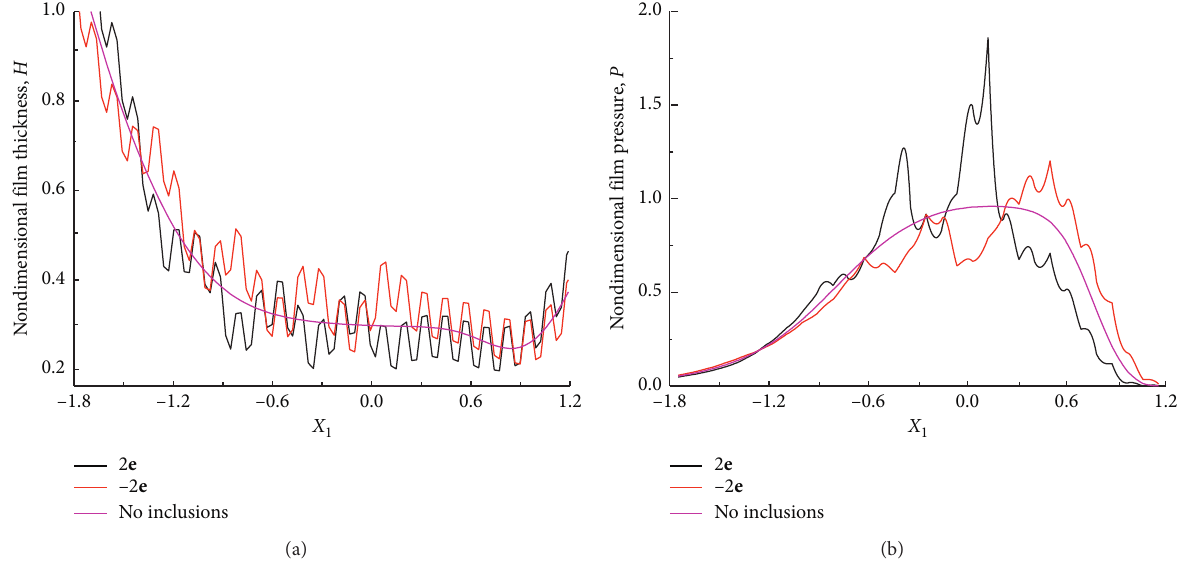
Figure 9: Nondimensional film thickness and pressure of the square roughness with eigenstrains, 2 e and − 2 e